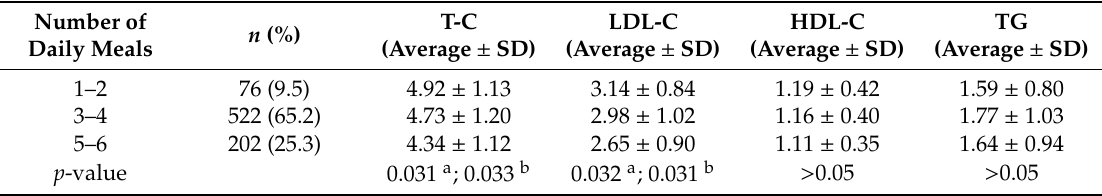
Table 3. E ff ect of the number of daily meals on lipid profile (mmol /